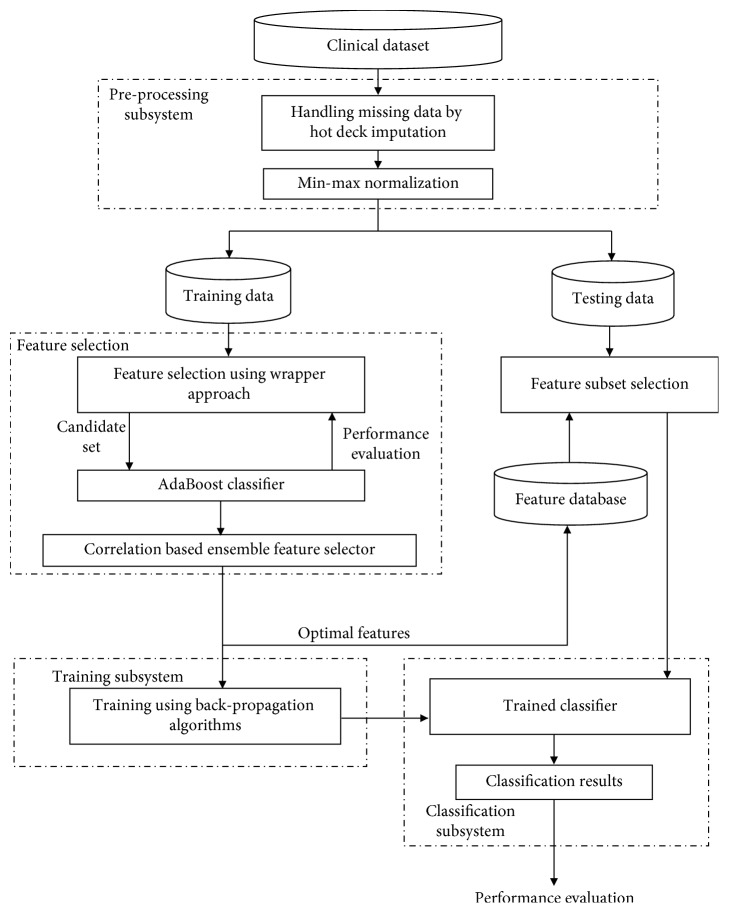
System framework.